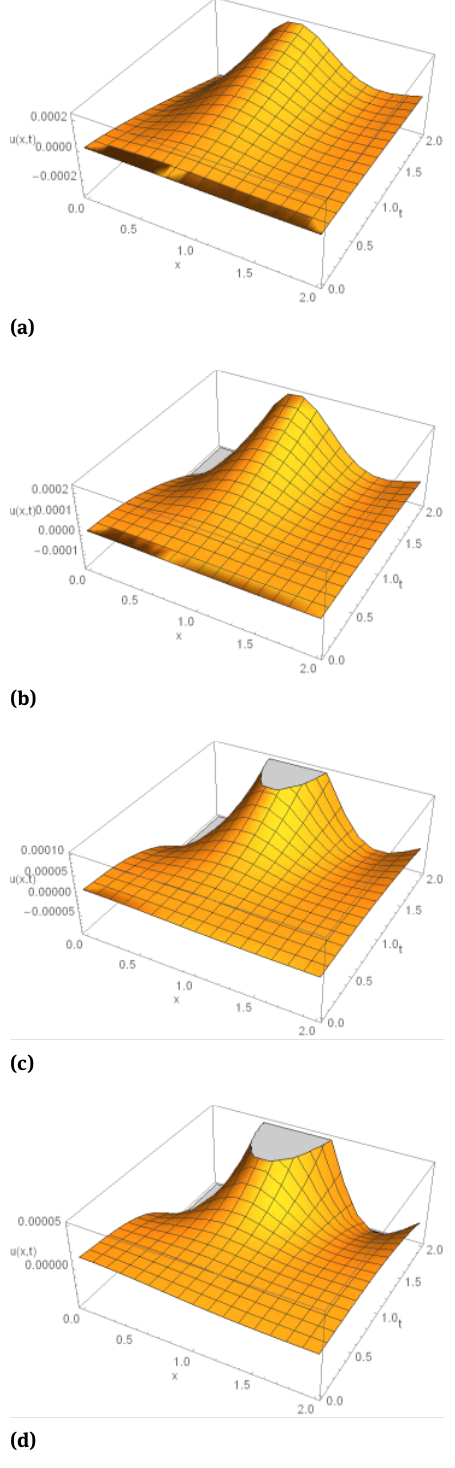
Figure 1: The surface graph of approximate solution v ( x , t ) for